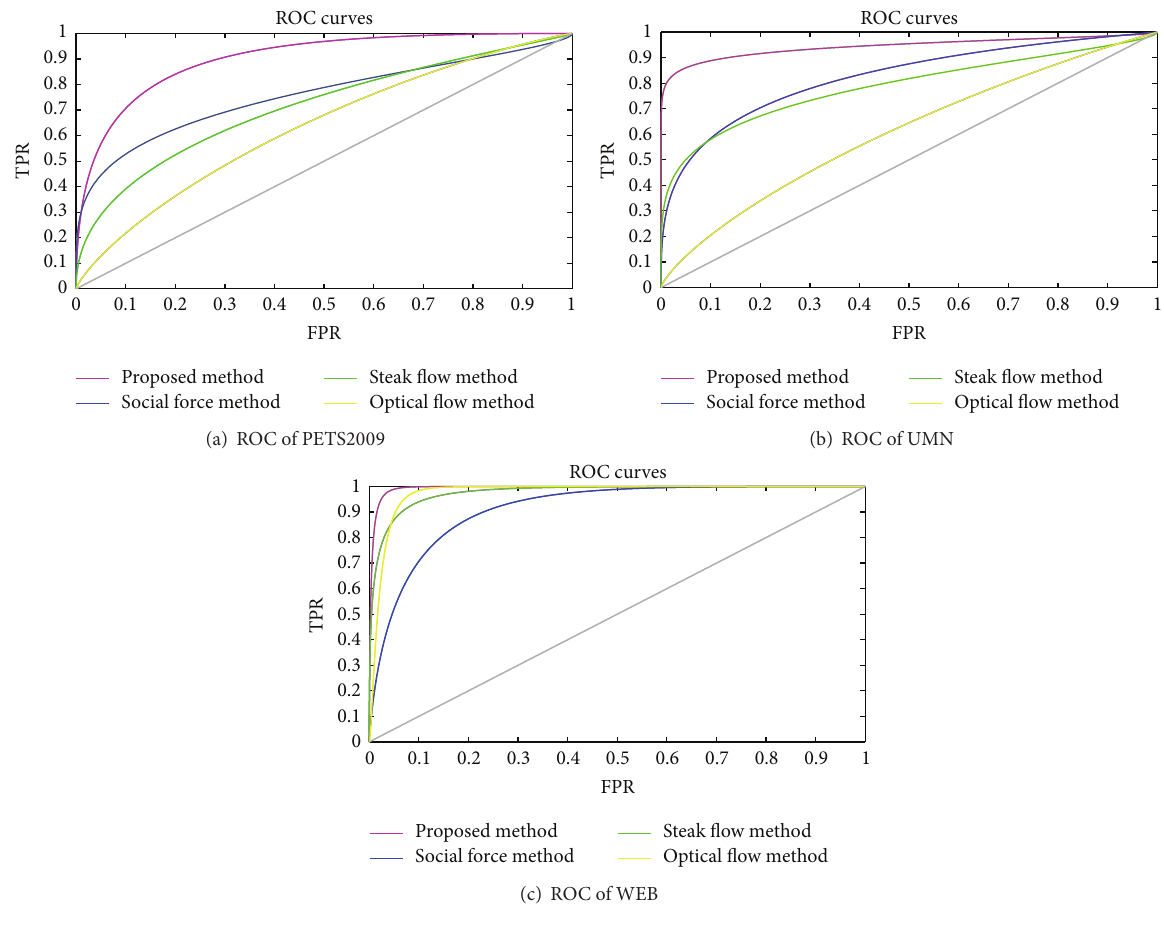
Figure 10: The ROCs for abnormality detection on three